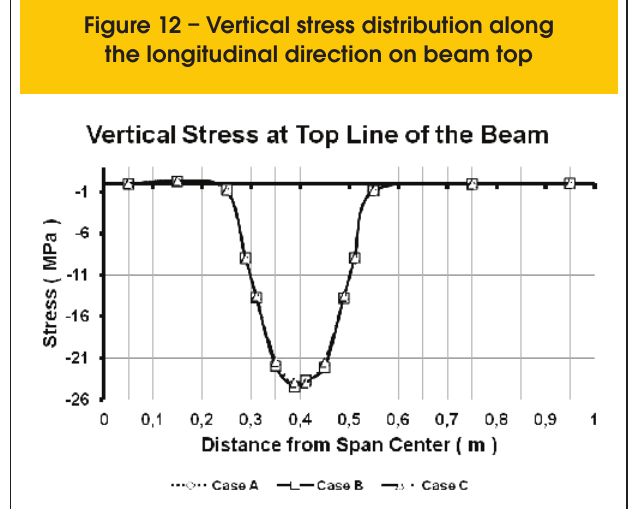
Figure 14 – Load strain curves at the span center section on beam